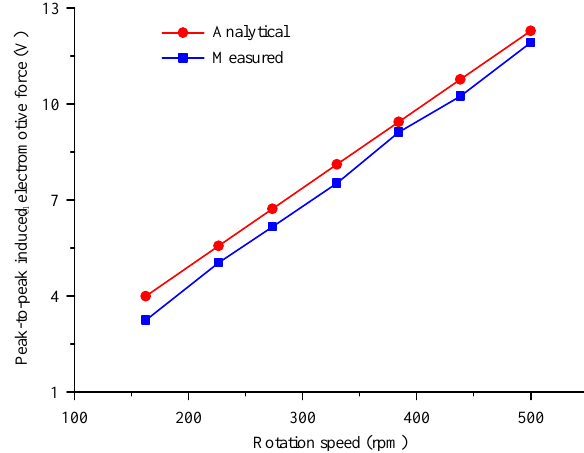
Figure 11. Measured and analytical peak-to-peak values of induced electromotive force varying with rotation speed.